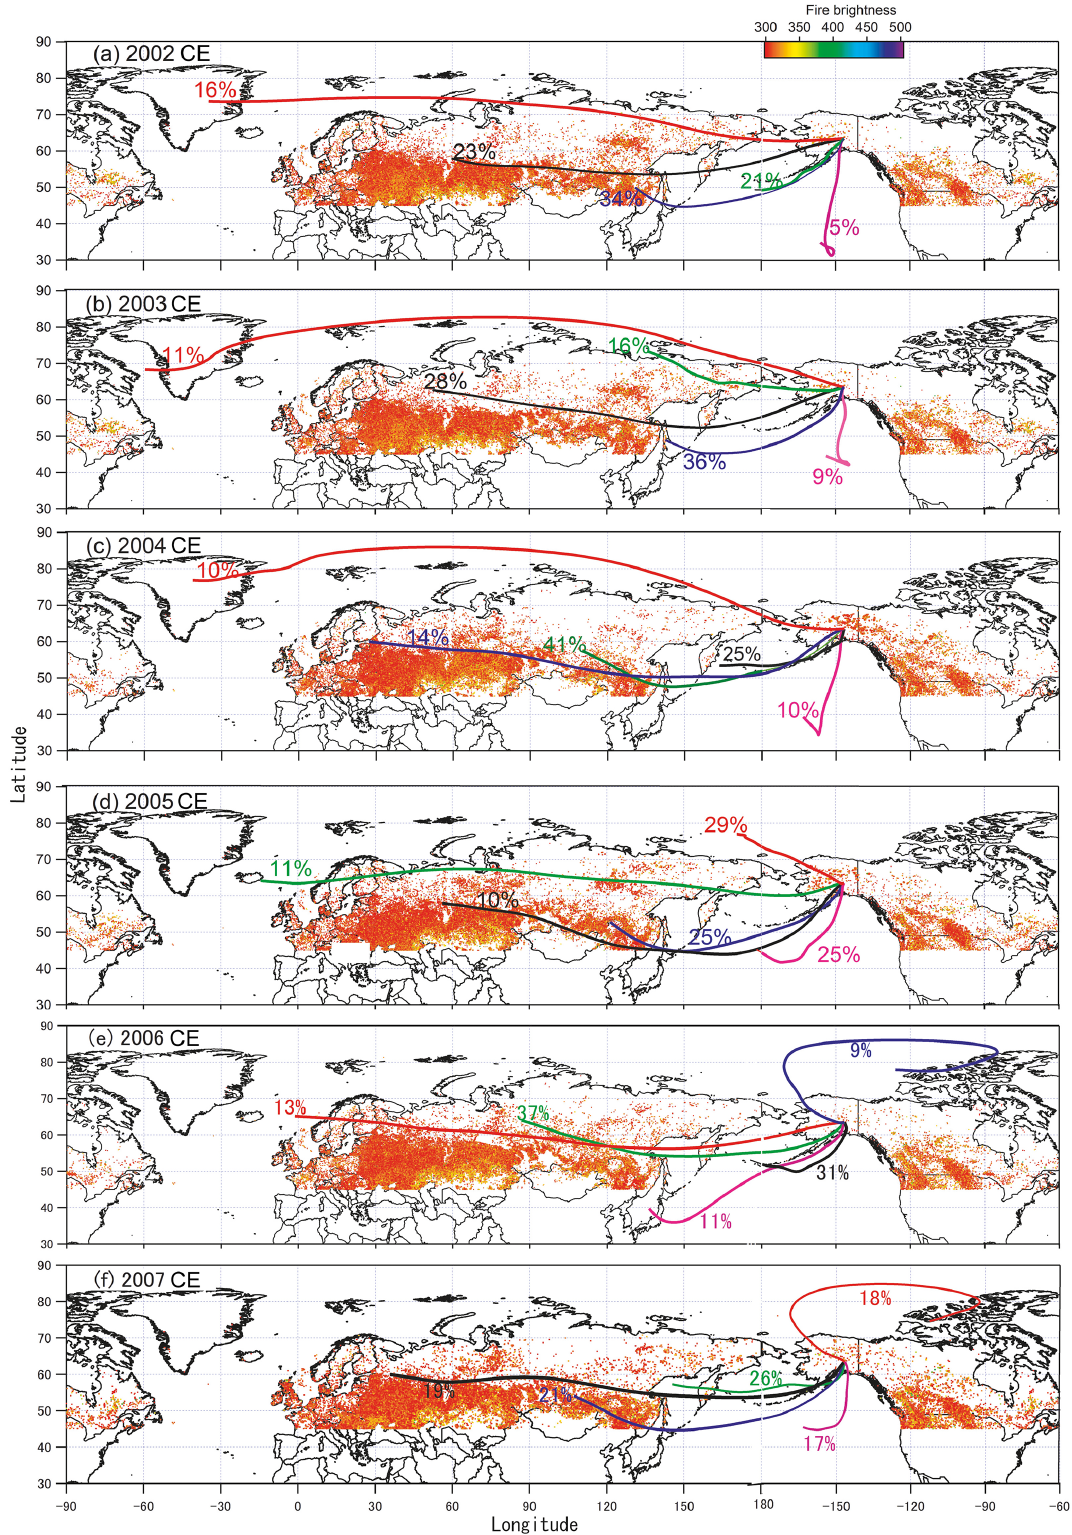
Figure 2. The MODIS fire spots together with 10d back-trajectory analysis (a–f) of Alaska from 2002 to